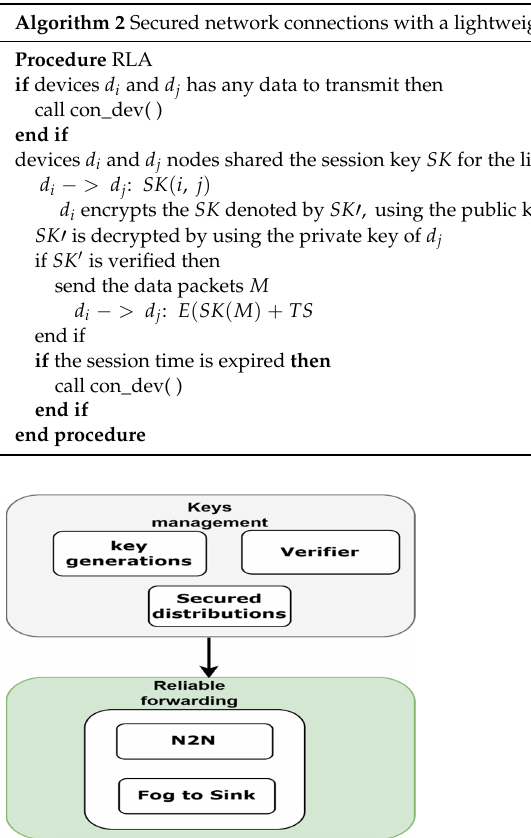
Figure 3. Developed components of the proposed